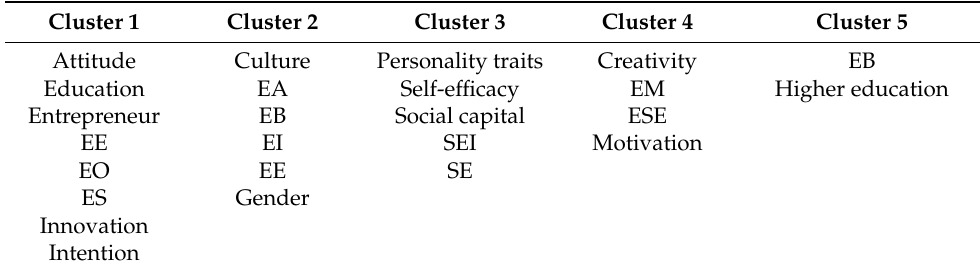
Table 13. Clusters related to documents published on EI